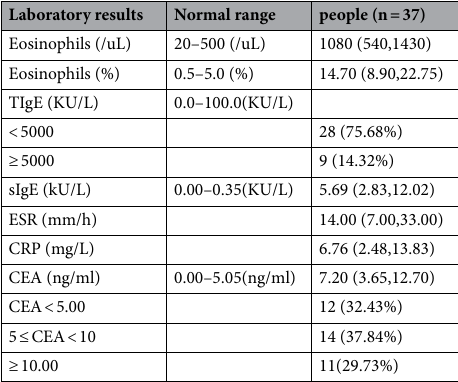
Table 4. Laboratory Characteristics of ABPA patients.